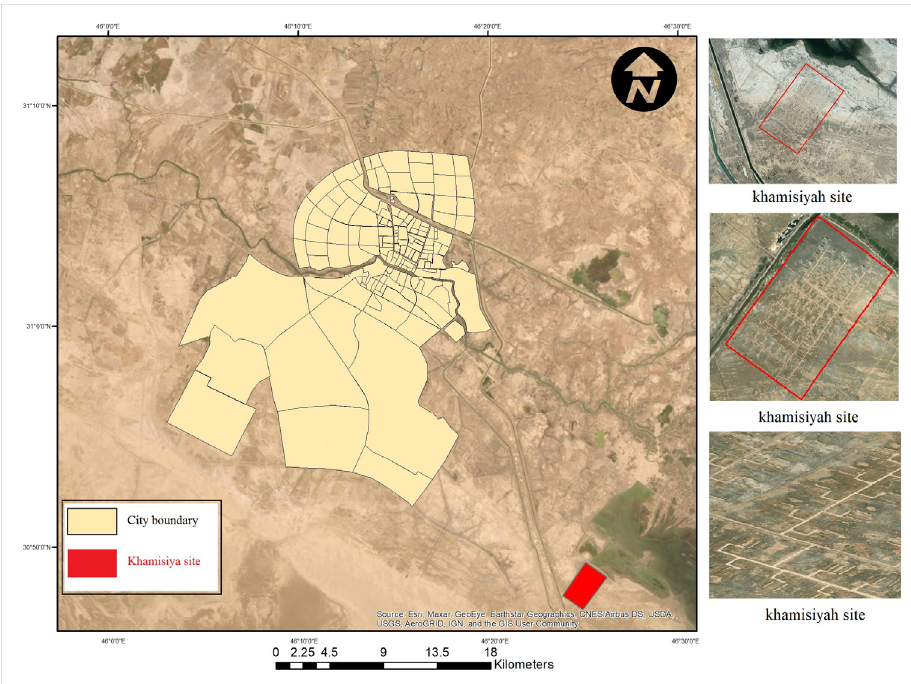
Figure 1. Location of Nasiriyah City. Upper left: location of Iraq on the world map. Bottom left: location of Nasiriyah City on the Iraq map. Right: map of Nasiriyah City showing the location of the ancient city of Ur (4000 BC). The brown area comprises 92 occupied neighbourhoods.